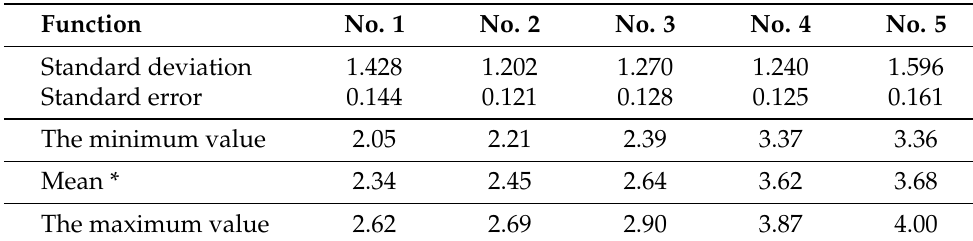
Table 3. Descriptive statistics for the dependent variable “Degree of Aesthetic Preference” for composition.